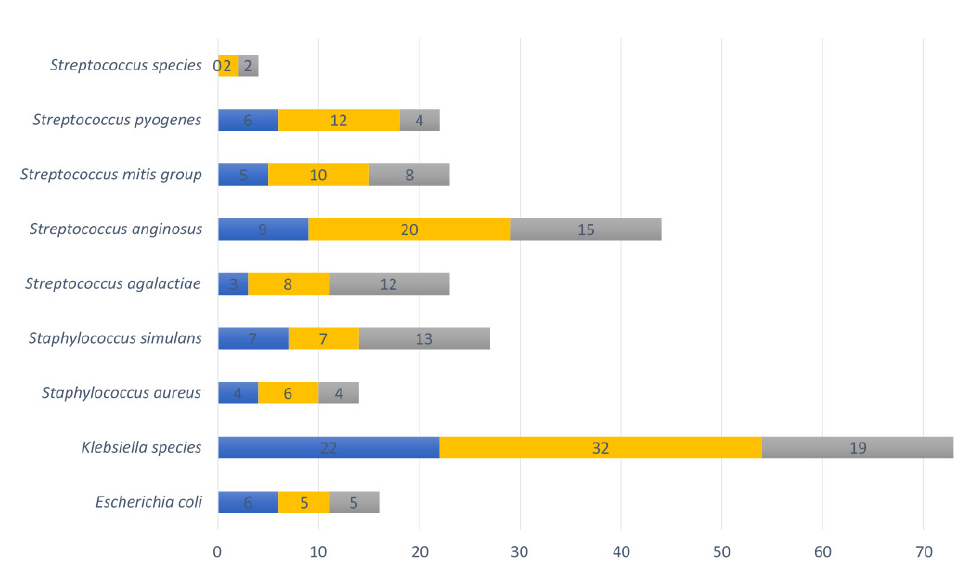
Figure 6. Nine pathobionts observed in vaginal samples per collection point. Numbers of vaginal samples detected with pathobionts at <20 weeks GA pregnancy collection ( n = 44), ≥ 20 weeks GA pregnancy collection ( n = 82), and post-delivery ( n = 44). Blue refers to the first timepoint during pregnancy, yellow to the second timepoint during pregnancy and grey to the post-delivery timepoint.